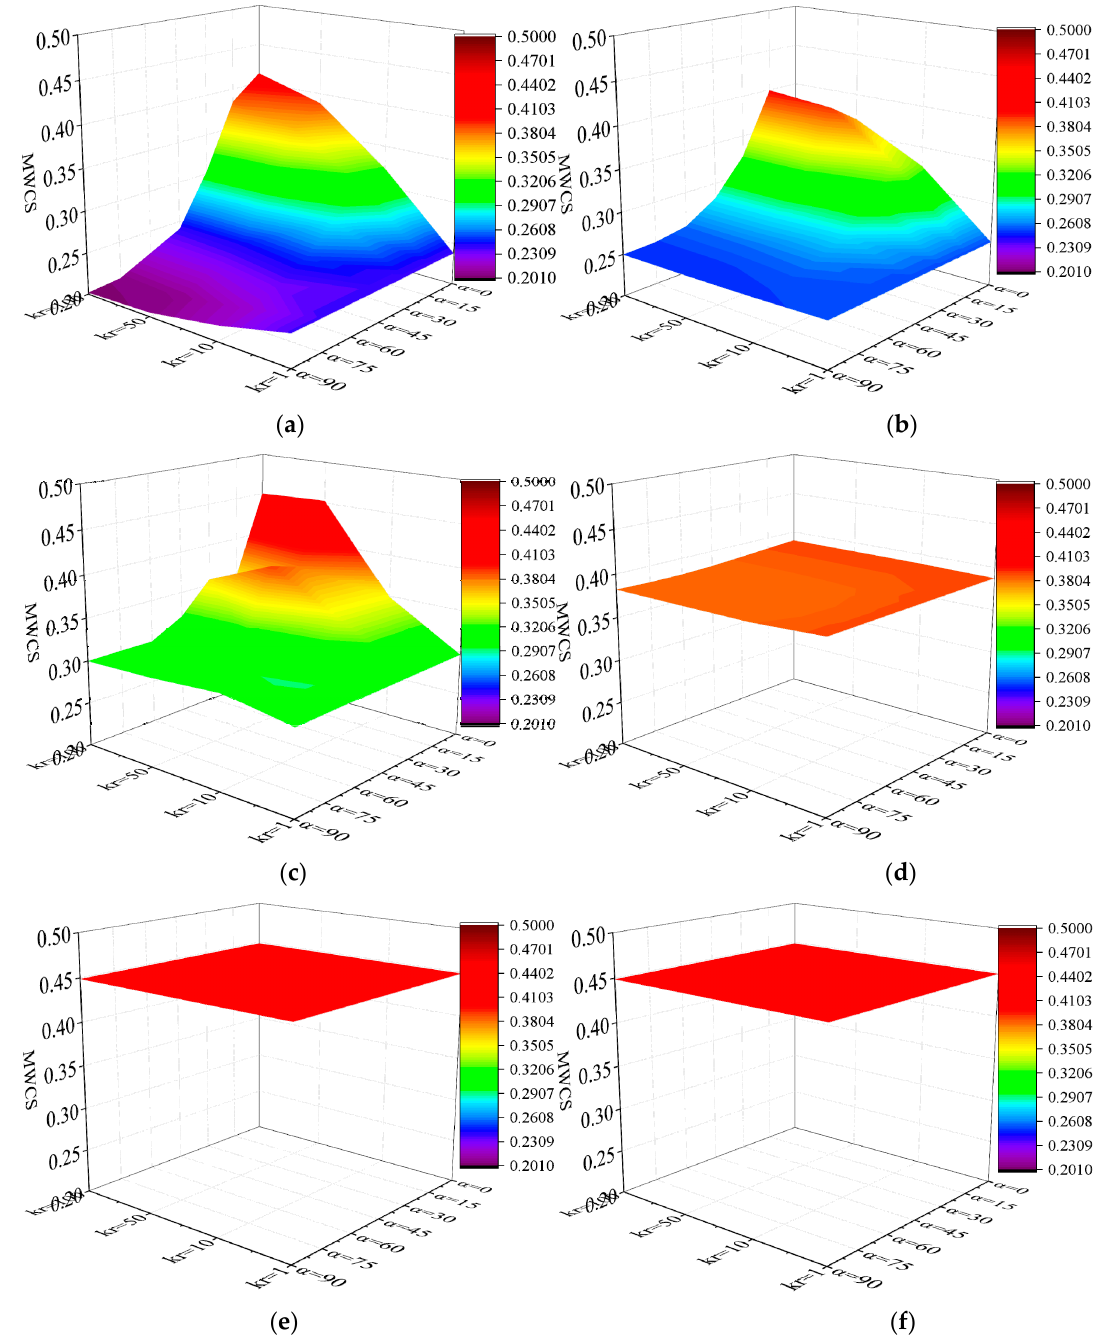
Figure 10. Variation of MWCS for clayey and sandy soil. ( a ) Top of the slope for sandy soil. ( b ) Middle of the slope for sandy soil. ( c ) Toe of the slope for sandy soil. ( d ) Top of the slope for clayey soil. ( e ) Middle of the slope for clayey soil. ( f ) Toe of the slope for clayey soil.